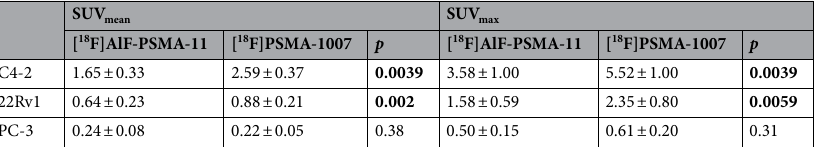
Table 1. SUV mean and SUV max values for [ 18 F]AlF-PSMA-11 and [ 18 F]PSMA-1007 uptake in C4-2 (high PSMA expression), 22Rv1 (low PSMA expression) and PC-3 (no PSMA expression). Values are expressed as mean ± SD. SUV = Standardized Uptake Value. Significant values are in